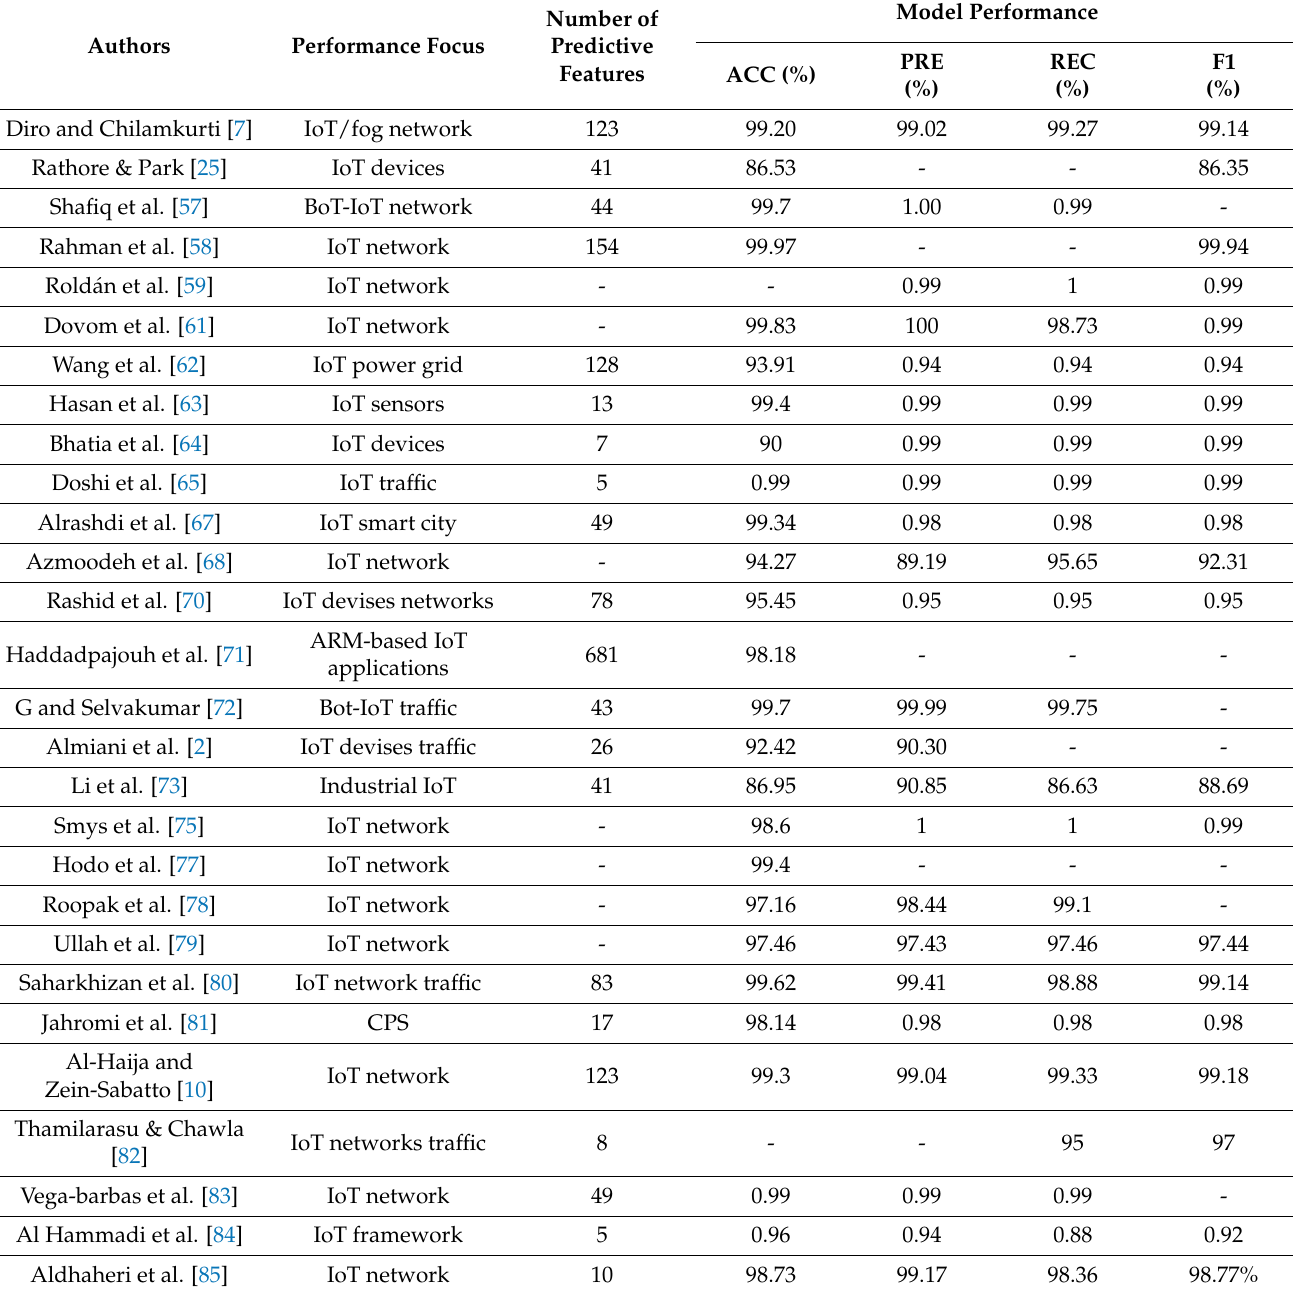
Table 6. Summary of studies classified based on model